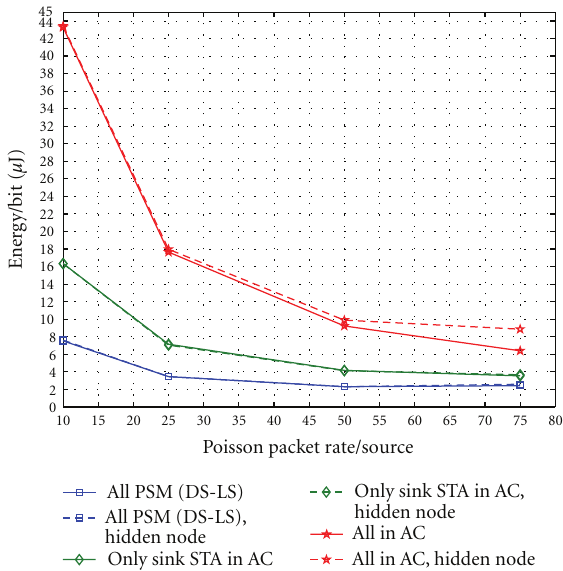
Figure 19: Energy/bit without or with hidden nodes. Solid lines are for Setup 1 (no hidden node) and dotted lines are for Setup 2 (hidden node exists).